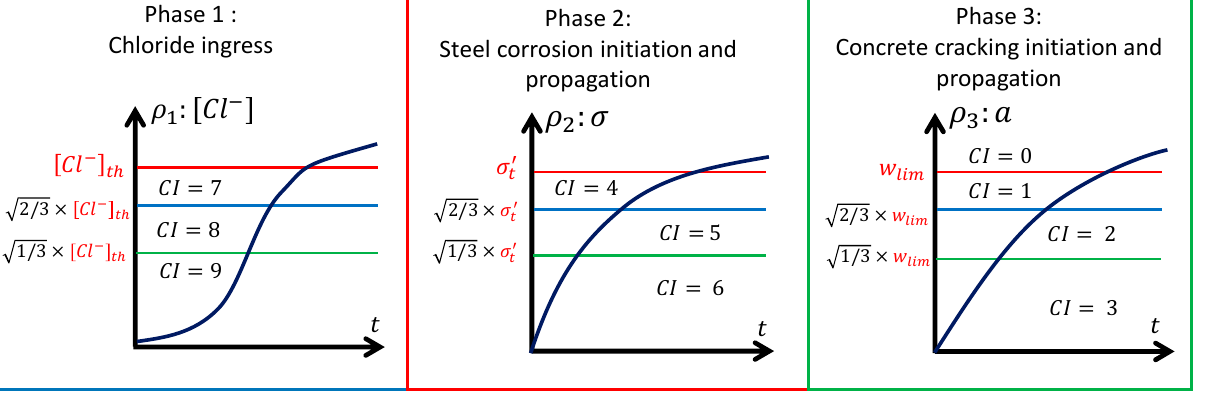
Figure 3. Condition indexing.